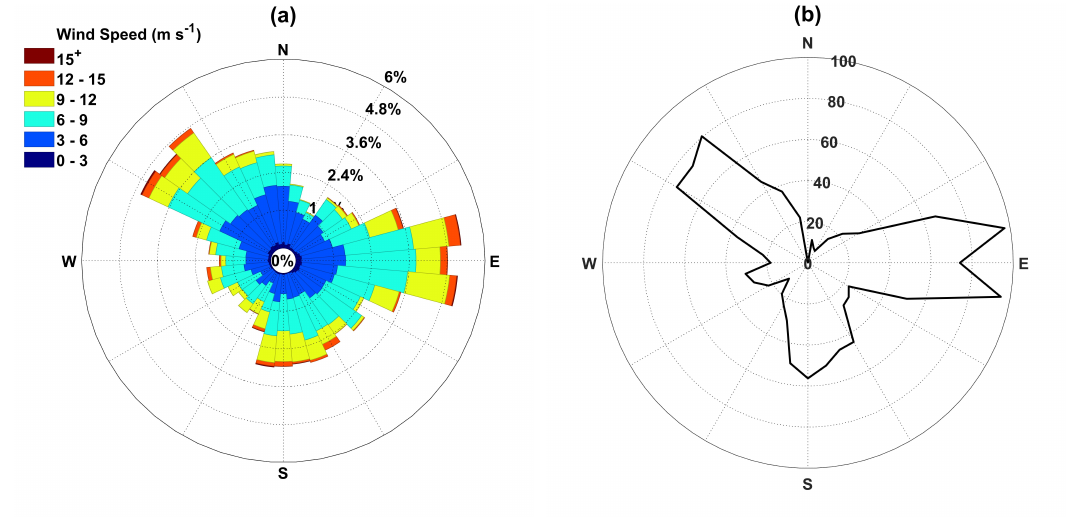
Figure 8. Distribution of wind and generated energy during the four-month period of study: ( a ) wind rose from SCADA data and ( b ) energy rose from SCADA data in MWh, only for periods when the turbine was operating. The energy rose is generated by considering bins of 10 ◦ , and integrating the total amount of energy generated for each bin in MWh.